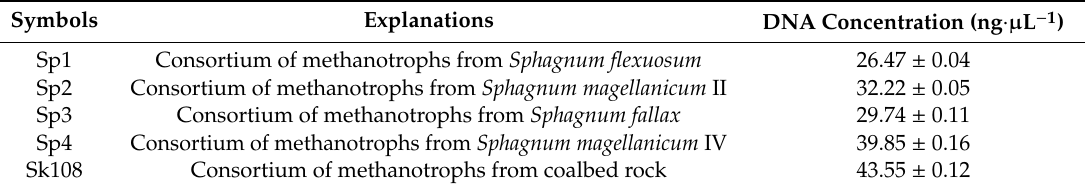
Table 1. List of samples with DNA content ( ±